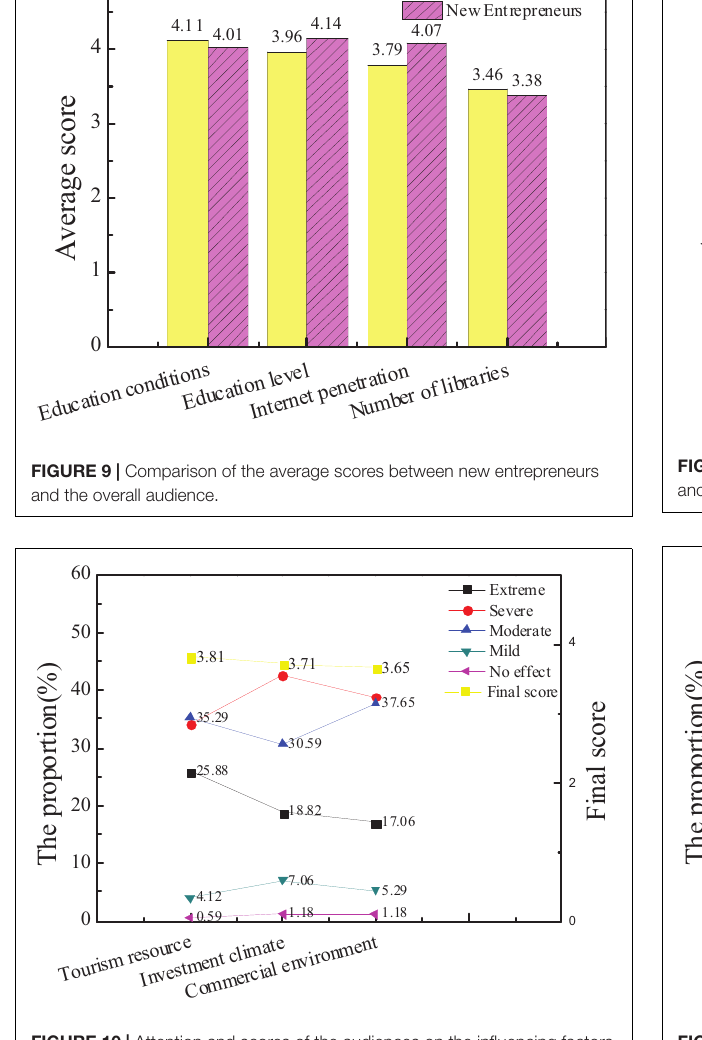
FIGURE 10 | Attention and scores of the audiences on the influencing factors of city economic image.